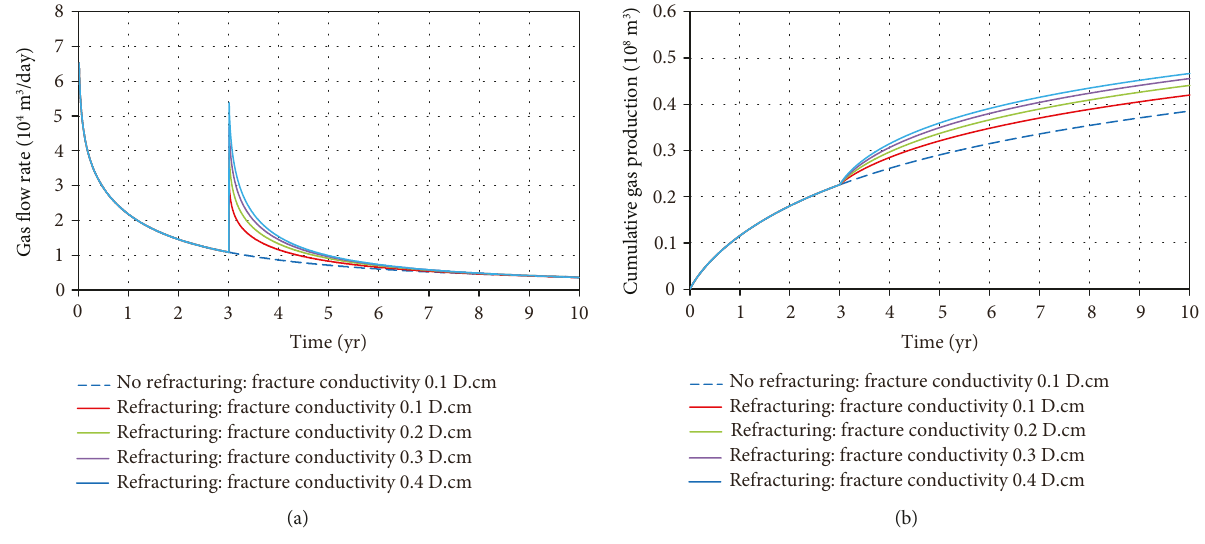
Figure 8: Well performance of refracturing through new perforation zones: (a) gas fl ow rate and (b) cumulative gas